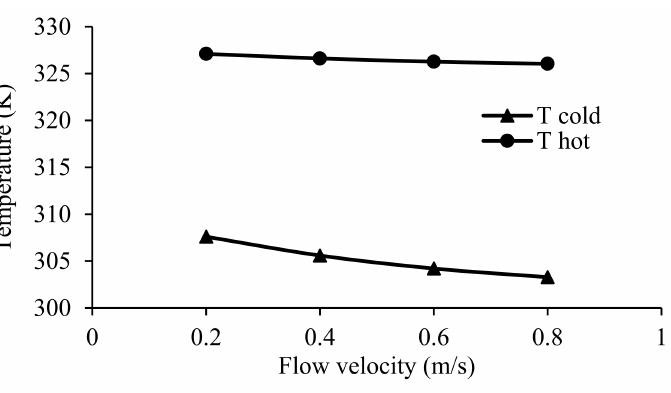
Figure 10. The relation between the flow velocity and the module’s hot and cold surface temperatures.